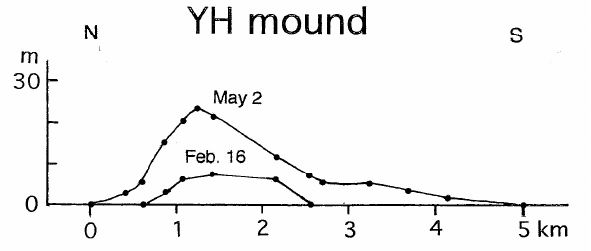
Fig. 10. Upheavals of YH (Yanagi-Hara) in 1944 (after Inoue,